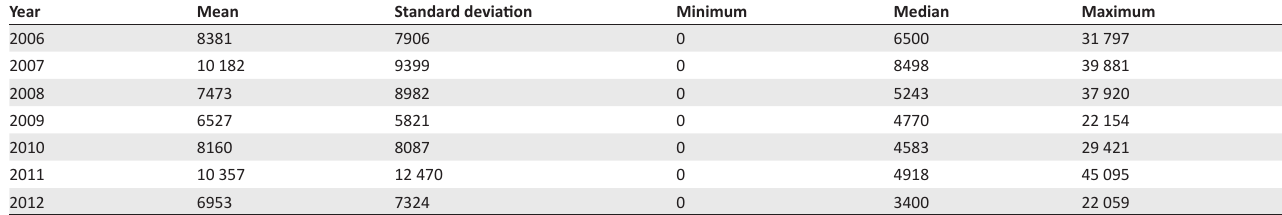
n = 21. FP, fixed pay. FIGURE 1: Graphical representation of the descriptive statistics for CEO fixed pay. TABLE 3: CEO short-term incentives summary (R ’000).